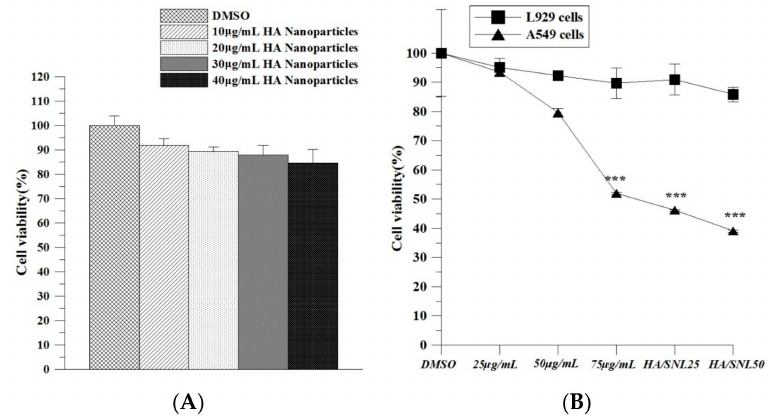
Figure 3. Cytotoxicity of HA nanoparticles, SNL and HA/SNL aggregates on L929 cells and A549 cells. ( A ) Viabilities of A549 cells treated with various HA nanoparticles concentrations; ( B ) Cell viability dose-response curves for L929 cells and A549 cells treated with SNL and HA/SNL aggregates over 24 h. The significant differences are based on comparisons with the L929 cells and A549 cells. *** p < 0.001.